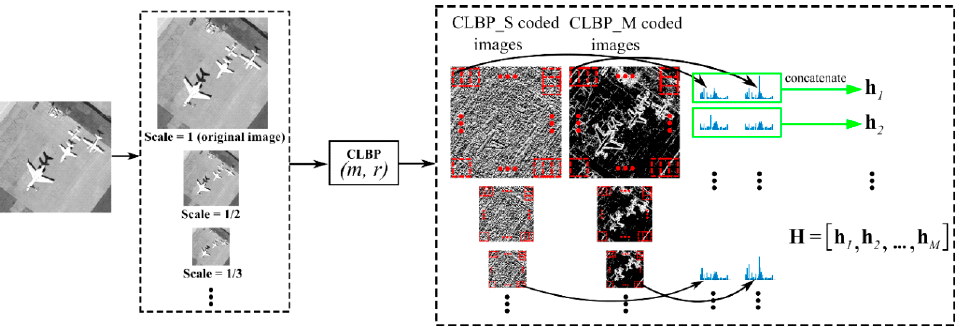
Figure 5. Patch-based CLBP feature extraction.